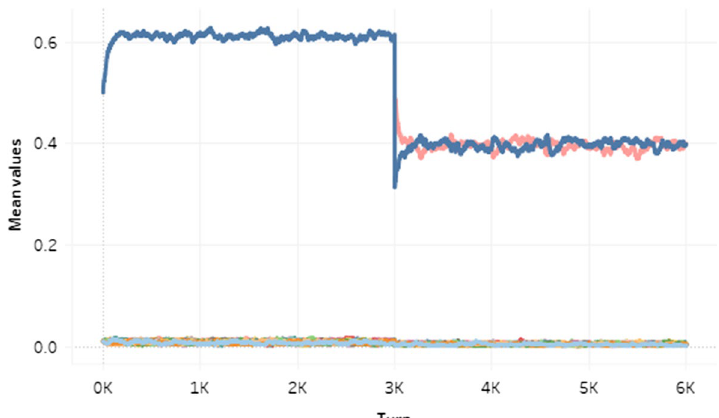
Fig. 3 Introduction of the cryptocurrency payments, case 1-A: Time series change of the mean of view. Case 1-A is a case in which cryptocurrency is not selected as a utility (no cryptocurrency agent), 1 unit is distributed to 50 people, all 50 people demand the cryptocurrency, and the view of 50 people is increased. Blue line is the fiat money good, red line is the cryptocurrency good, and other colors represent remaining goods. After turn 3001 of the cryptocurrency good introduction, both the fiat money good and the cryptocurrency good acquire a monetary function